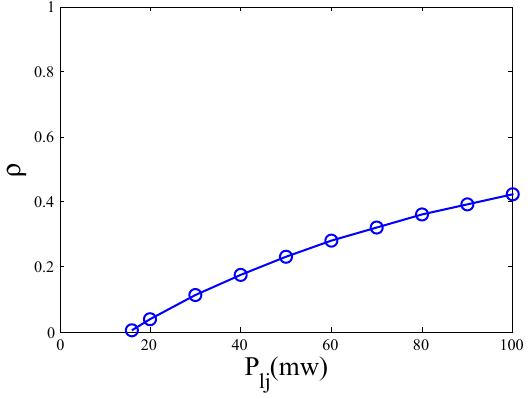
Figure 8. The splitting ratio under different interference